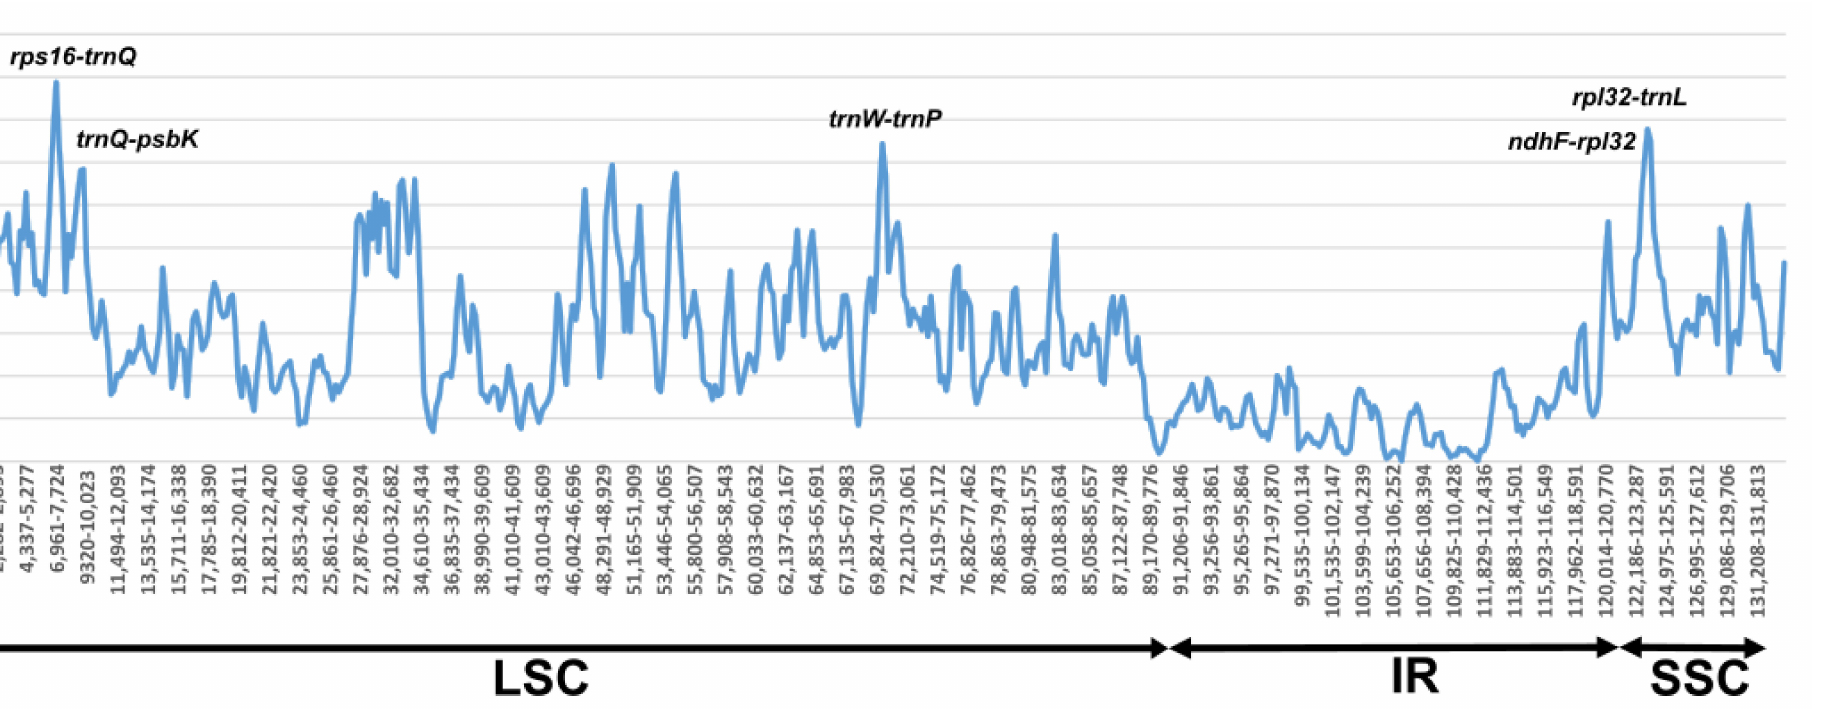
Figure 6. Comparison of the nucleotide variability ( Pi ) values in nine Persicaria chloroplast